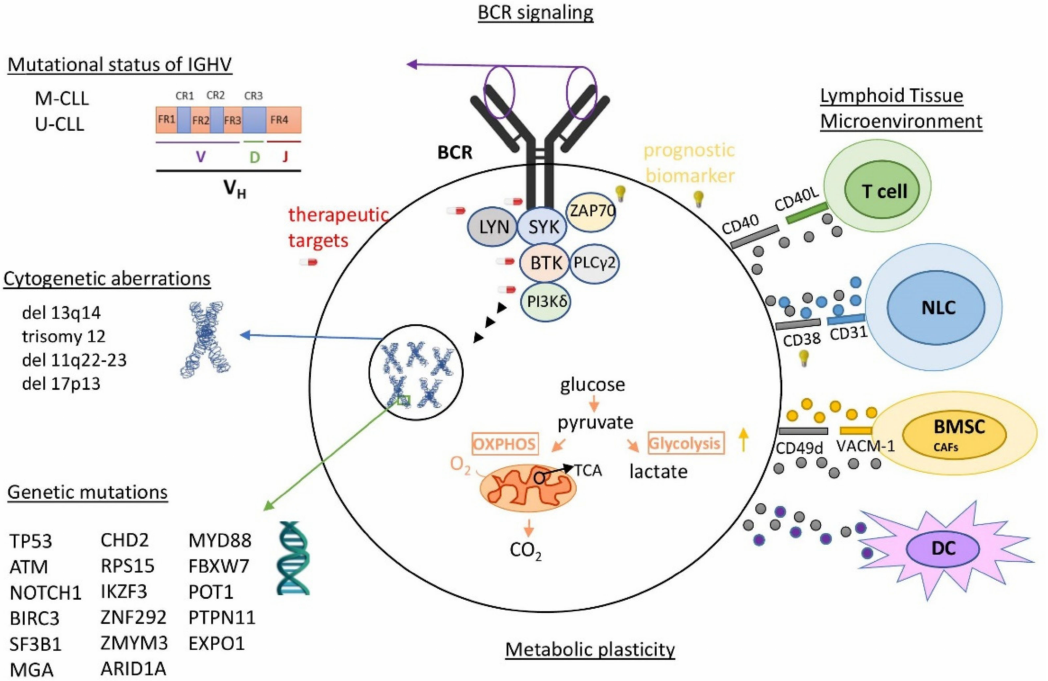
Figure 1. Currently known heterogeneity in the pathophysiology of CLL. Some of the most important elements of CLL pathophysiology are: (1) highly varying genomic mutations, (2) loss or addition of large amounts of chromosomal material, (3) mutational status of variable region of IGHV, (4) frequent activation of BCR signaling and (5) continuous proliferating signals from the cancerous microenvironment. IGHV: immunoglobulin heavy chain variable region genes; M-CLL: mutated CLL; U-CLL: unmutated CLL; BCR: B cell receptor; NLC: nurse-like cells; BMSC: bone marrow stromal cells; DC: dendritic cells; OXPHOS: oxidative phosphorylation; TCA: citric acid